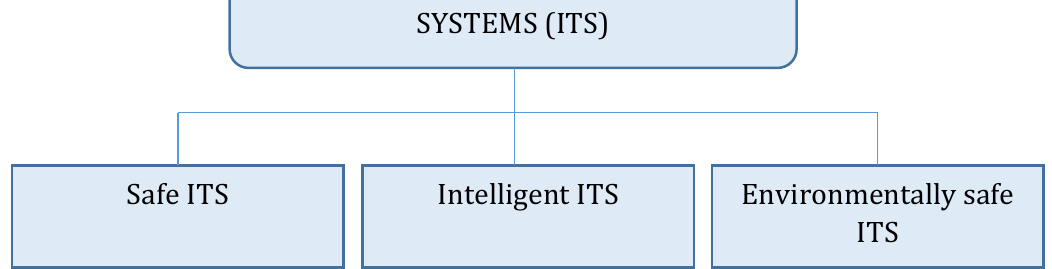
Fig. 1. Sub-categories of intelligent transportation